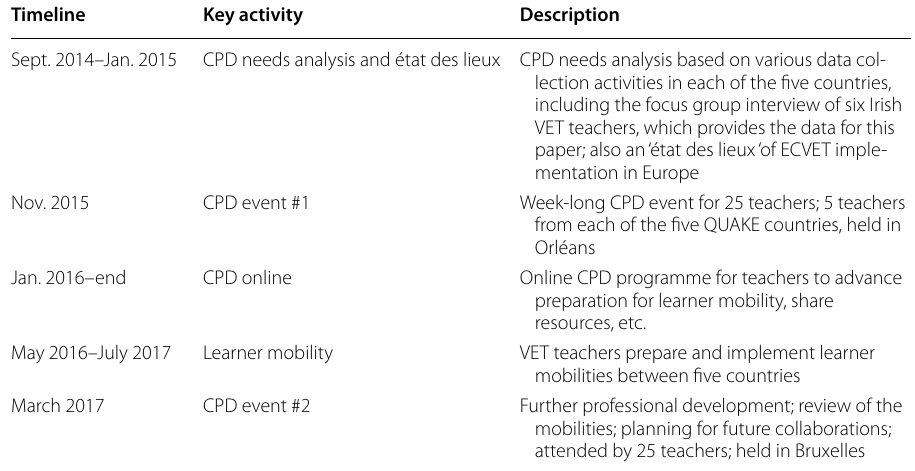
Table 1 Key activities from project commencement (Sept. 2014) to project end (Aug. 2017)